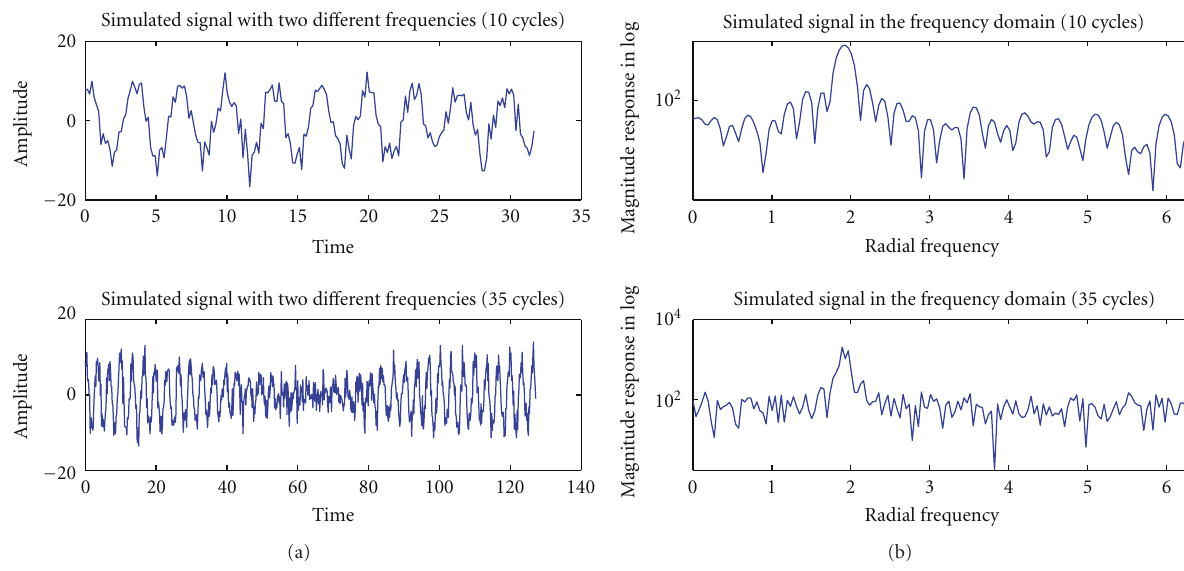
Figure 1: Two simulated signals with di ff erent lengths in the time and frequency domain. (a) Two simulated signals with di ff erent lengths in the time domain. (b) Two simulated signals with di ff erent lengths in the frequency domain.